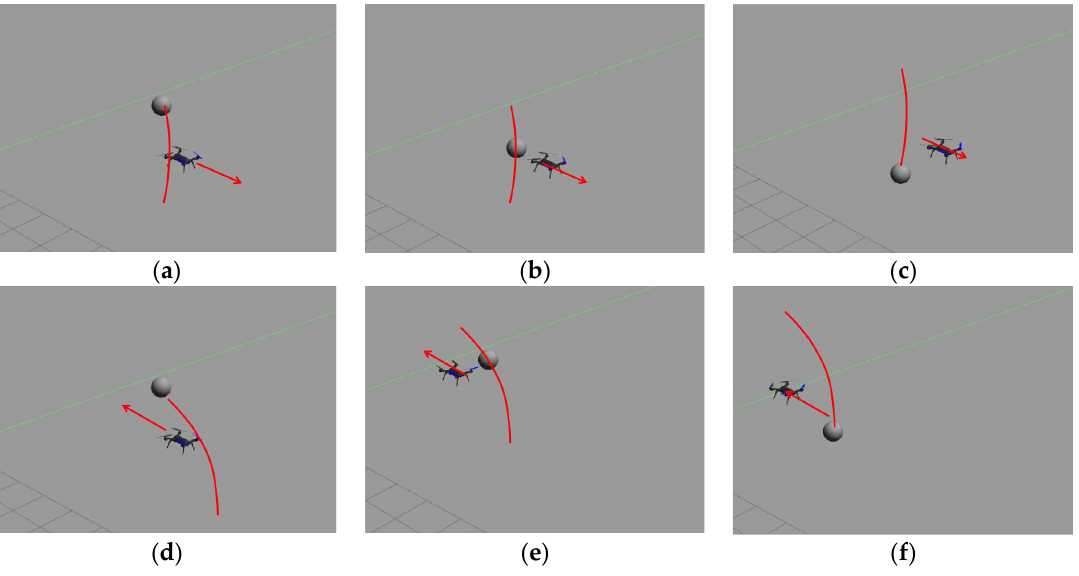
Figure 14. Six typical images during UAV’s moving: ( a ) The basketball is flying from the front left of the UAV, so the UAV moves right; ( b ) The UAV moves right; ( c ) The UAV avoids the basketball successfully; ( d ) The basketball is flying towards the front of the UAV; ( e ) The UAV moves left; ( f ) The UAV avoids the basketball successfully.